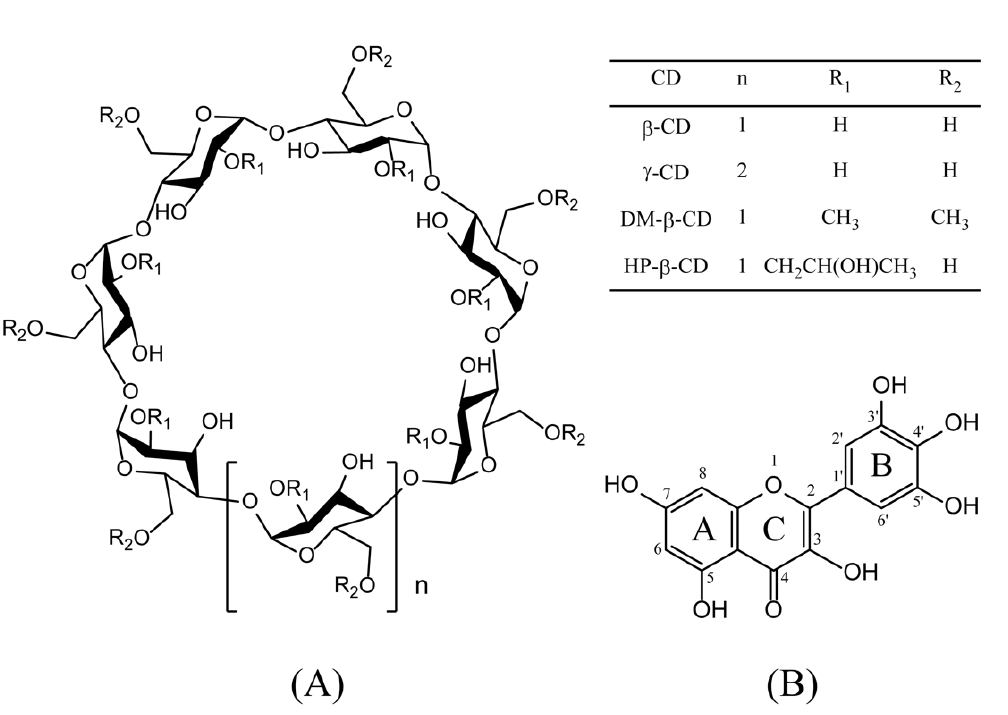
Figure 1. Chemical structures of cyclodextrins (CDs) ( A ) and myricetin ( B ). Abbreviations: β -cyclodextrin, ( β -CD); γ -cyclodextrin, ( γ -CD); heptakis- O -(2-hydroxypropyl)- β -cyclodextrin, (HP- β -CD); and heptakis- O -(2, 6-di- O -methyl)- β -cyclodextrin, (DM- β -CD).